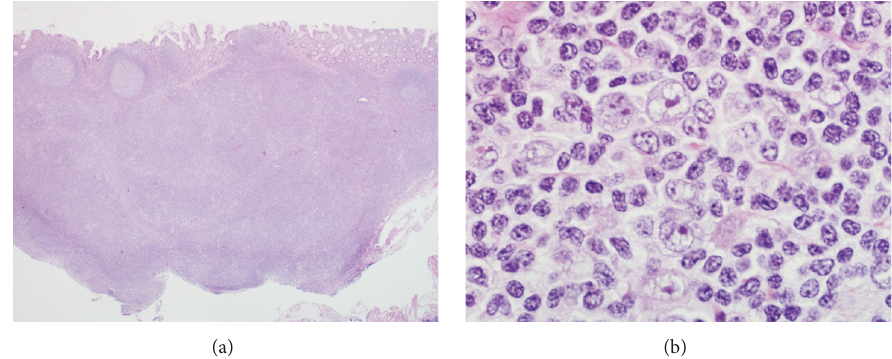
Figure 2: Morphologic features of the ileal lesion. (a) Low-power image of an H&E stain shows a vaguely nodular infiltrate with several adjacent reactive secondary lymphoid follicles. (b) High-power image of an H&E stain shows scattered large cells with multilobated nuclei (lymphocyte predominant cells) in a background of small lymphocytes and occasional histiocytes.